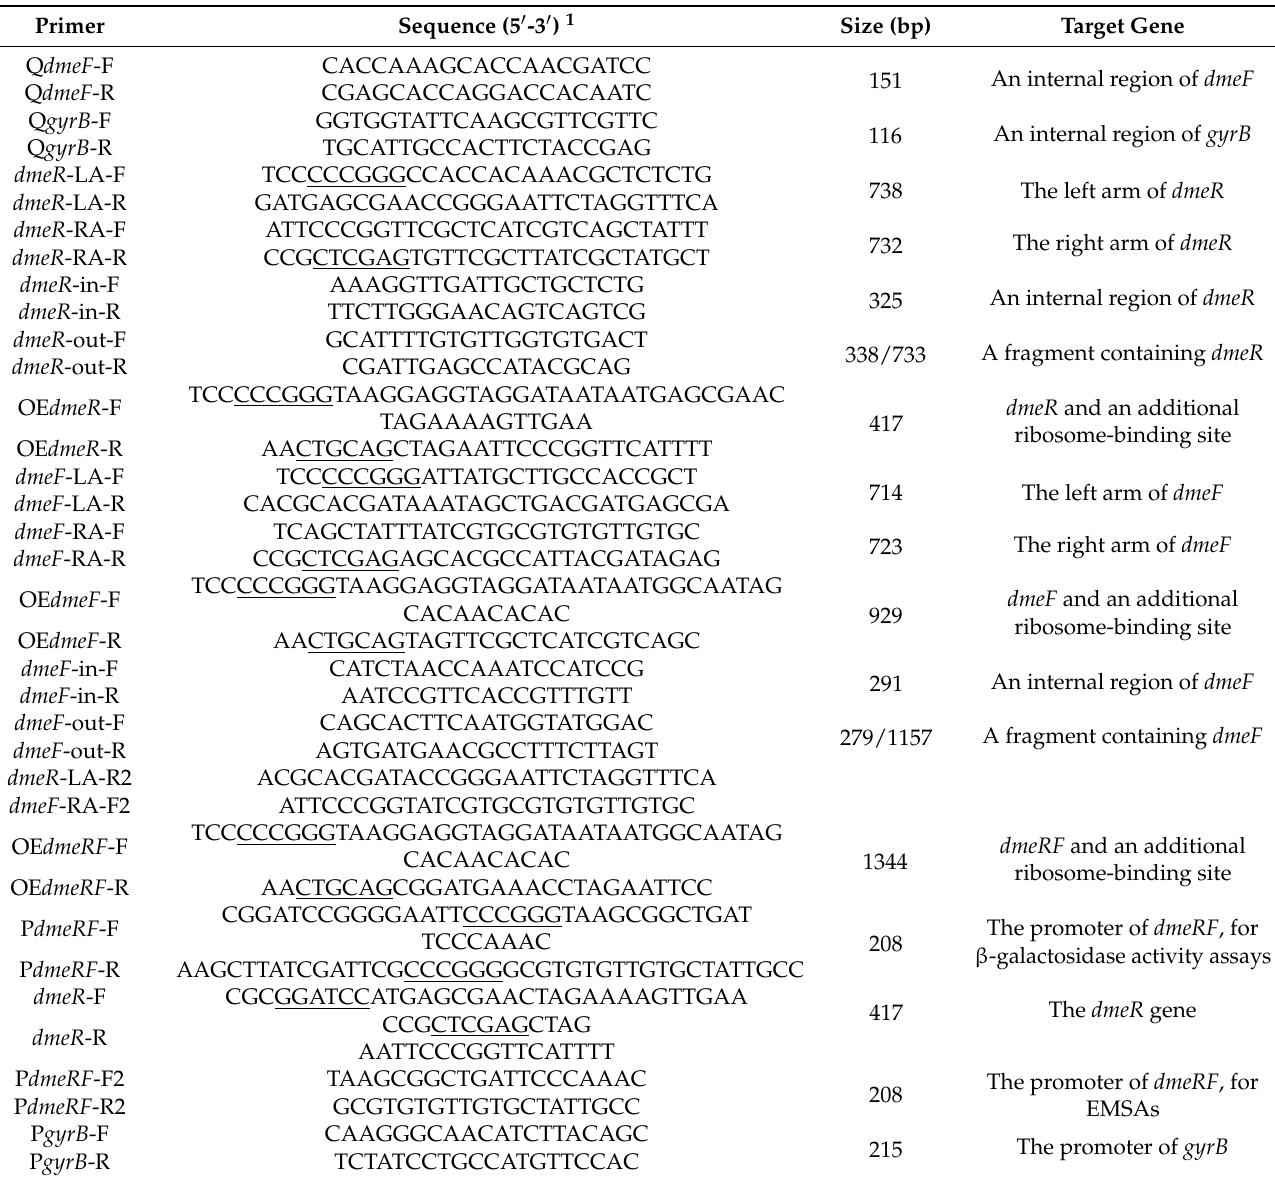
Table 2. Primers used in this